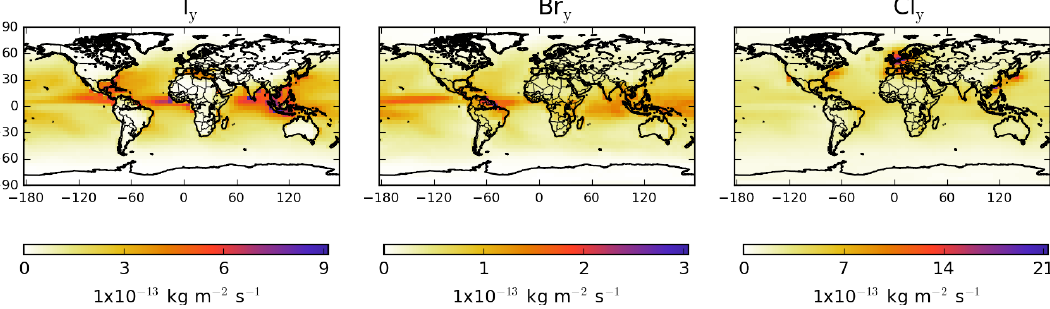
Figure 2. Annual global X y ( X = Cl, Br, I) deposition ( X y defined in Appendix C). Values are given in terms of mass of halogen deposited (kg X m − 2 s − 1 , X = Cl, Br,